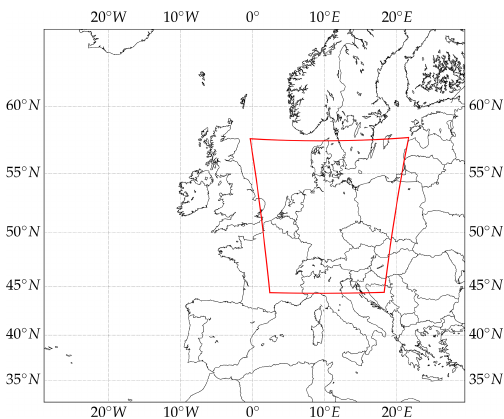
Figure 1. Map of the European SEVIRI domain, as defined in Deneke and Roebeling (2010). The red borders indicate the Ger- many domain, which is the focus of this